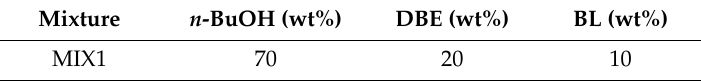
Table 9. Composition of the prepared ternary